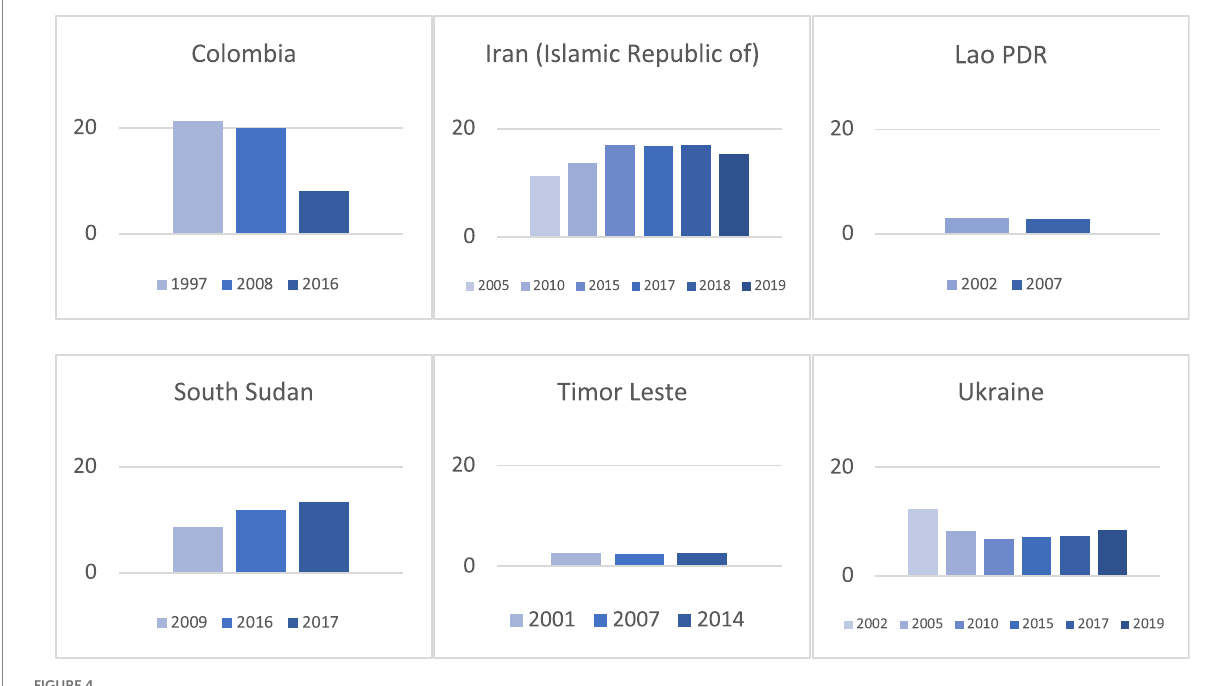
FIGURE 4 Evolution of the percentage of the total population with household expenditures on health >10% of total household expenditure or income (SDG